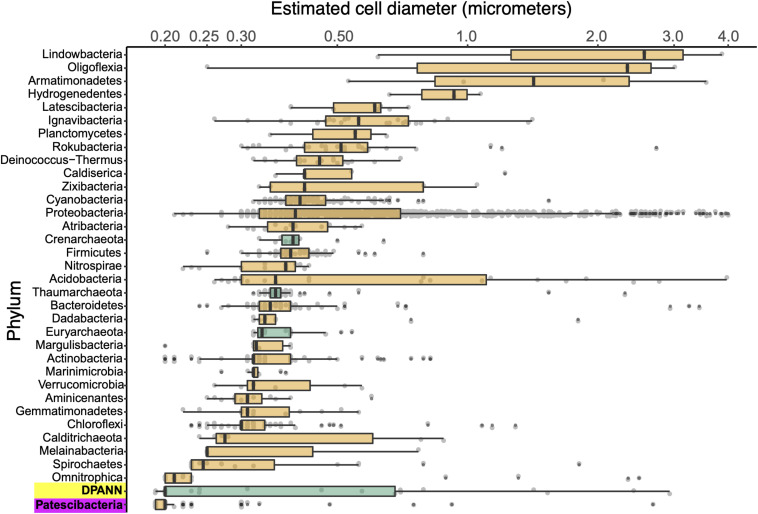
Phylum-resolved cell diameters. Solid black bars indicate medians; boxes represent the interquartile ranges (IQR) of the 1st (Q1) and 3rd (Q3) quartiles; whiskers denote the minimum (Q1 – 1.5∗IQR) and maximum (Q3 + 1.5∗IQR) values; outliers outside of the whiskers are marked by black dots. Orange indicates Bacteria and green indicates Archaea. A pairwise ranked-sum Wilcoxon test confirmed that the median diameter of Patescibacteria (highlighted in magenta) was smaller than most other phyla (27/36 phyla with p-values < 0.05; Supplementary Table S5). The median diameter of DPANN (highlighted in yellow) was not significantly different from other archaea (1/36 phyla with p-values < 0.05; Supplementary Table S5), likely due to the large variability in DPANN cell diameters. Individual cell diameters are available in Supplementary Table S1 and pairwise p-values are located in Supplementary Table S5.